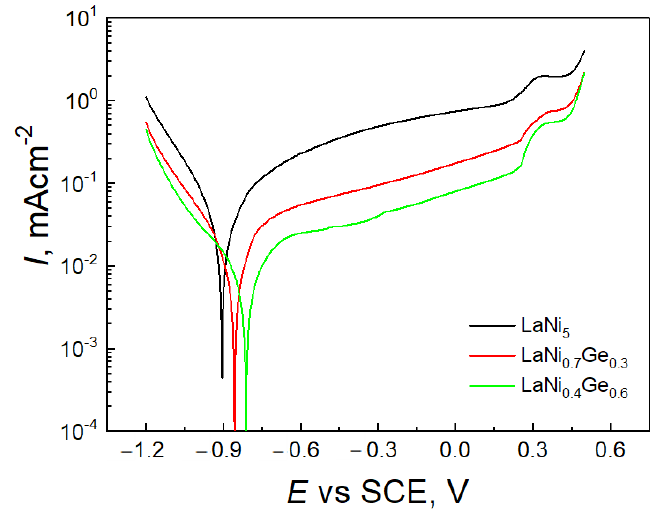
Figure 4. Polarization curves of LaNi 5-x Ge x alloys recorded in 6 M KOH solution at a scan rate of 10 mV s −1 .